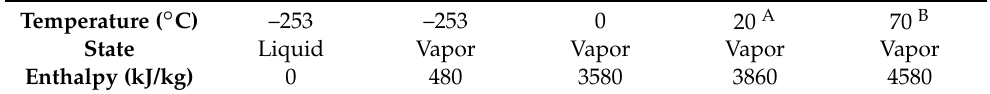
Table 3. Properties of hydrogen.